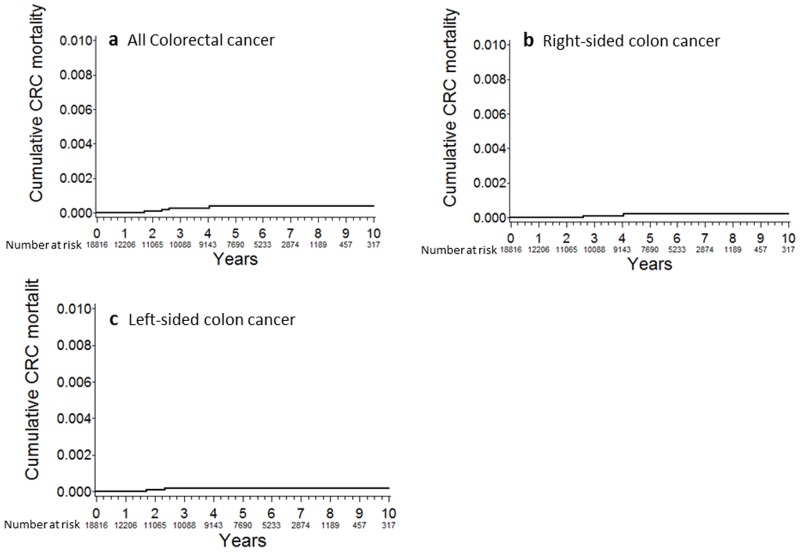
Cumulative colorectal cancer mortality.(a) All colorectal cancer; (b) Right-sided colon cancer; (c) Left-sided colon cancer.